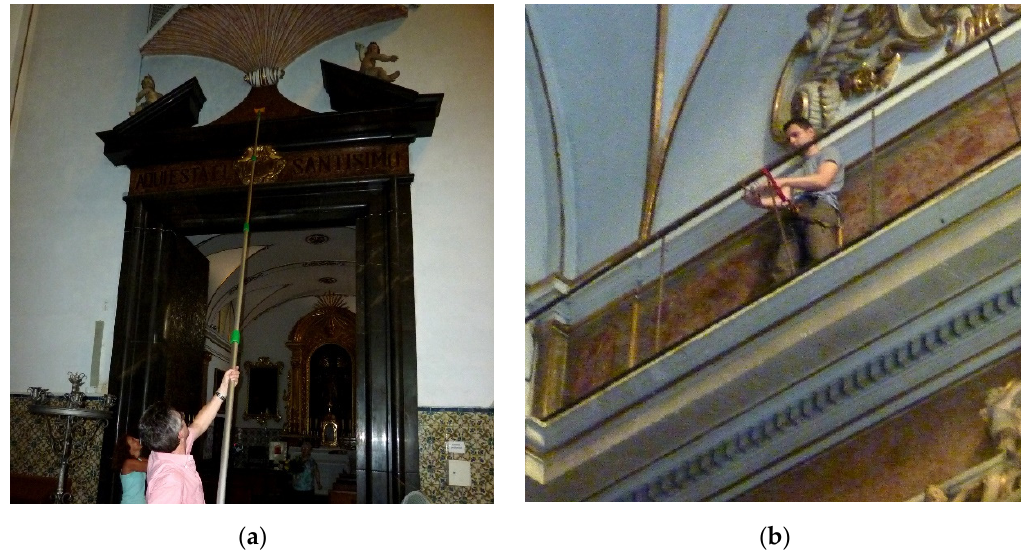
Figure 4. ( a ) Installation of sensor nodes at heights up to 9 m. ( b ) Installation of the sensor nodes clamped at above 12 m to the security banister of the cornice on top of all pilaster capitals around the entire perimeter of the central nave.